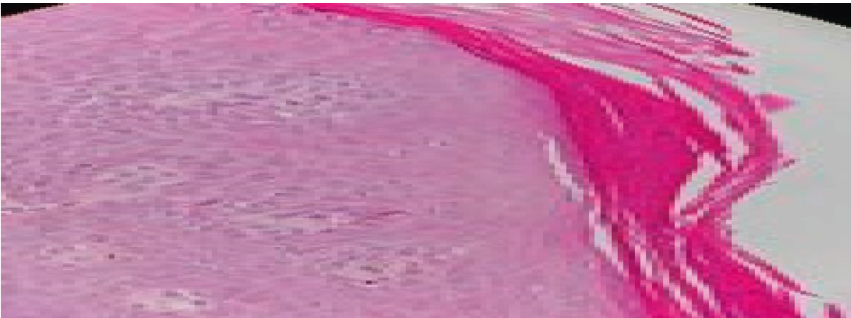
Figure 2: Parakeratosis, acanthosis, psoriasiform epidermal hyperplasia, and edema in capillary dermis.